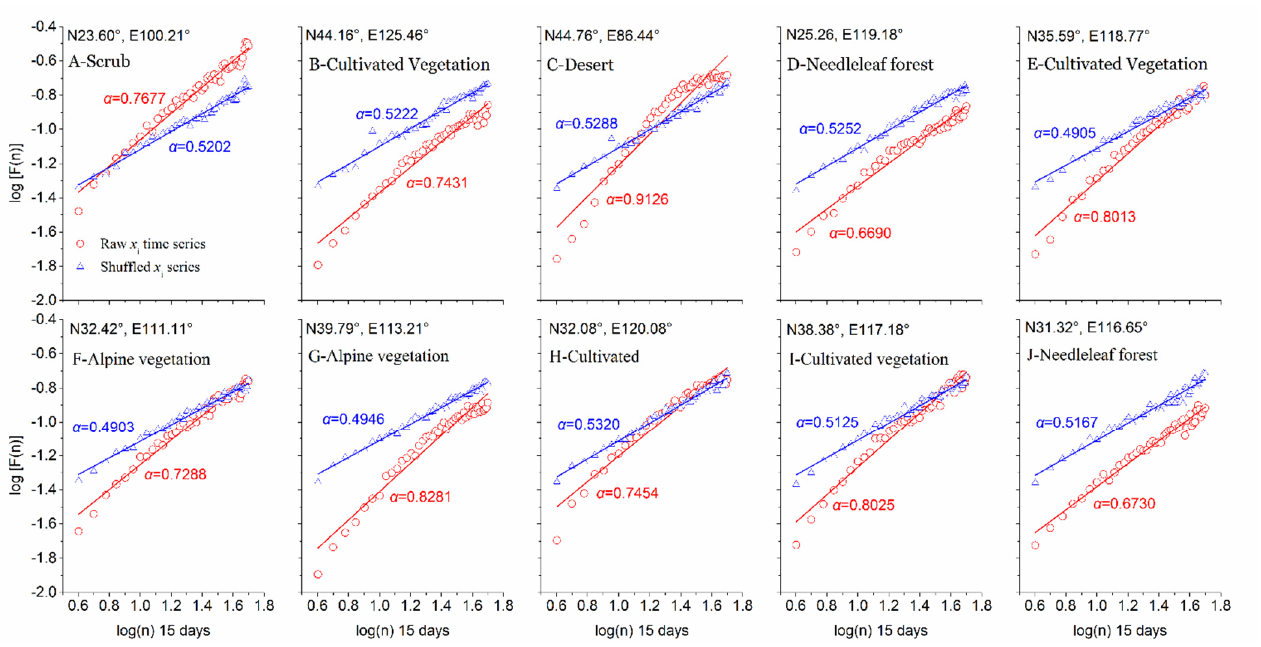
Figure 4. The root-mean-square series and DFA results of fitting for the NDVI time series (red) and shuf fl ed series (blue) at the individual pixel